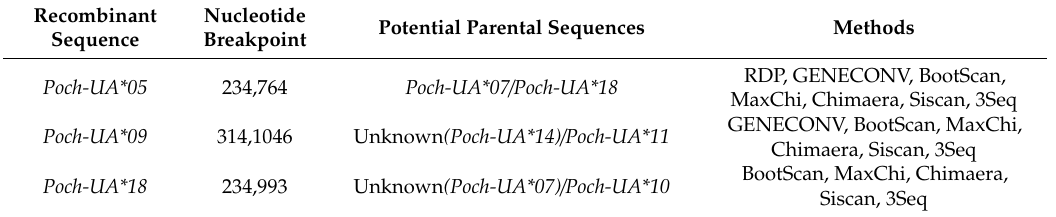
Table 3. Recombination test using the RDP4 program.